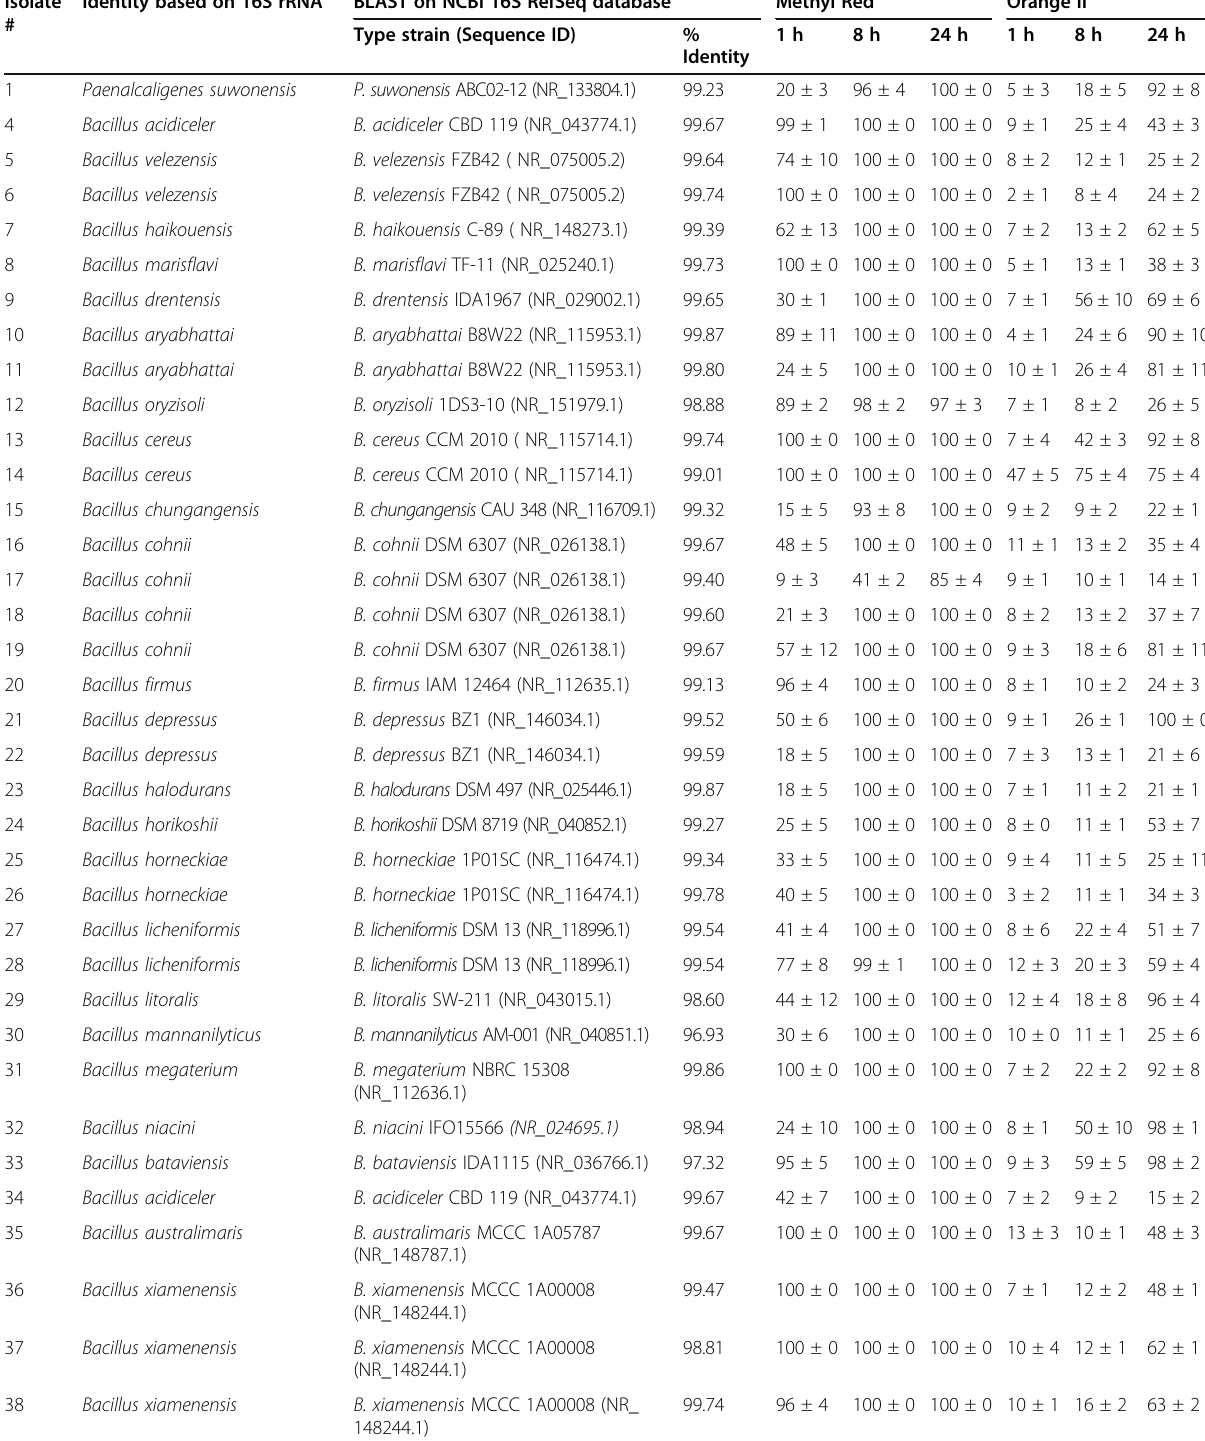
Table 1 Degradation (%)of Methyl Red and Orange II by 79 bacterial isolates a Isolate